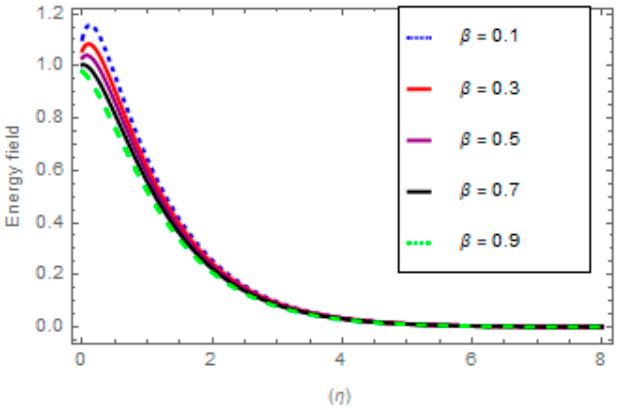
Figure 13. Result of β via θ ( η ) .